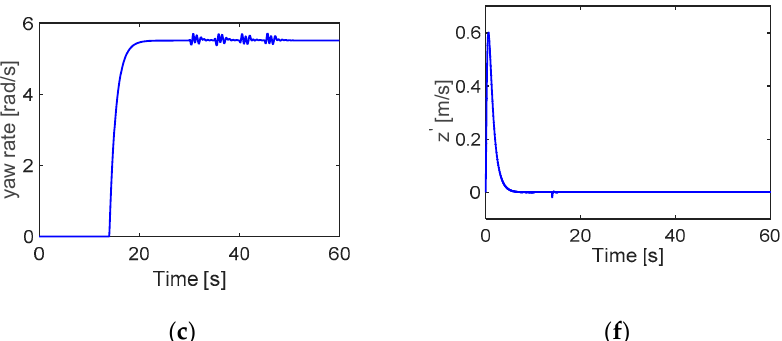
Figure 12. Angular rates and linear velocities for scenario 2: ( a ) Roll rate, ( b ) Pitch rate, ( c ) Yaw rate, ( d ) velocity of x-direction, ( e ) velocity of y-direction, and ( f ) velocity of z-direction.